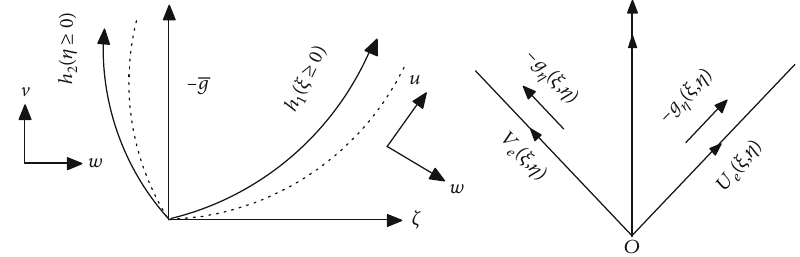
Figure 1: The fl ow con fi guration and the coordinate